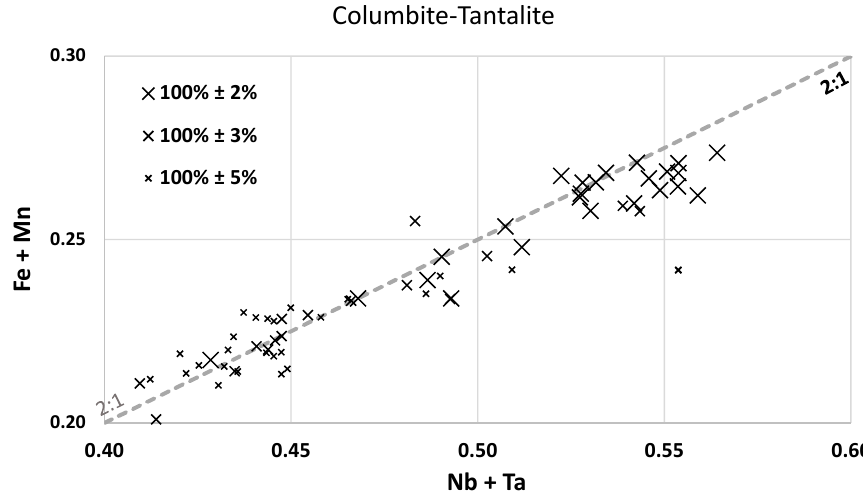
Figure 10. Quadrilateral plot of columbite-tantalite elemental composition. Plotted based on normalised moles of cations.